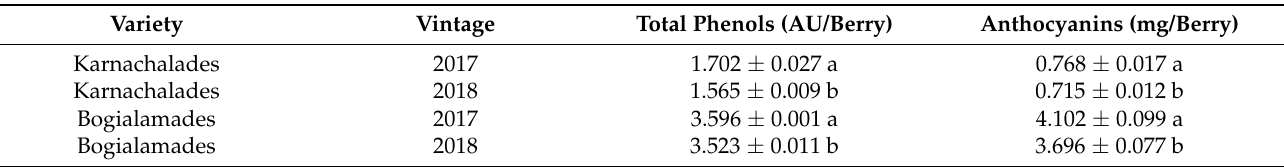
Table 2. Results from One–Way Analysis of Variance (ANOVA) with Tukey’s test, between total phenols and total anthocyanins in grape berries according to Iland method.